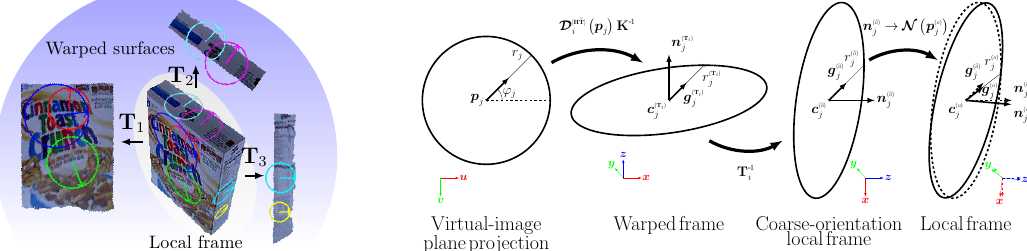
Figure 6. ( a ) keypoints detected on the warped surfaces are remapped back to the original input local frame to eliminate their per-surface parameterization. The resulting elliptical keypoints not only resemble those of affine region detectors but also vary covariantly with the object geometry and are invariant to viewpoint changes; ( b ) each keypoint is remapped from the virtual image plane of the smooth surface viewpoint invariant representation to the local frame of the original input by applying several transforms. The keypoint is first unprojected to the 3D space (Section 2.6.1), then its basis is changed to the local frame (Section 2.6.2). Finally, its orientation is corrected (Section 2.6.3). Refer to Section 2.6 for annotation and technical